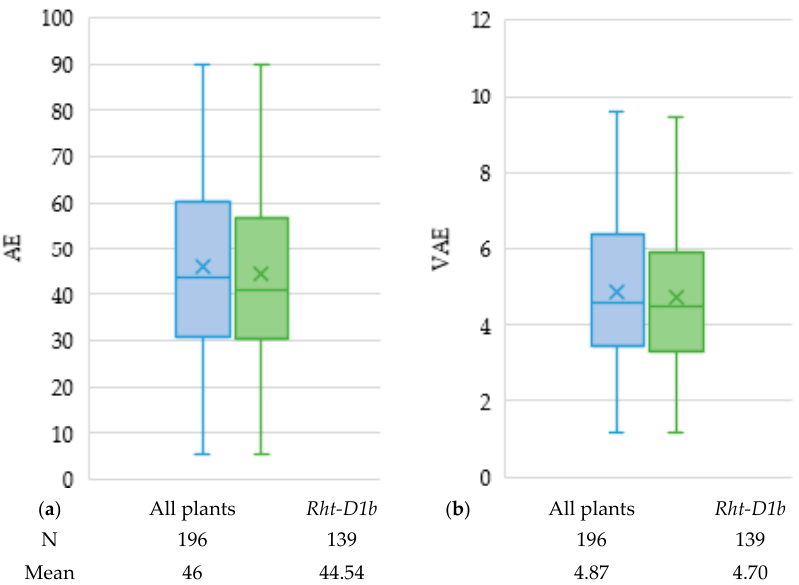
Figure 2. Box plots showing AE ( a ) and VAE ( b ) for genotypes carrying dwarfing gene allele Rht- D1b . N represents the total number of genotypes for the whole set (bleu) and the genotypes carrying Rht-D1b (green) and the mean values associated with each group. AE, anther extrusion; VAE, visual anther extrusion.